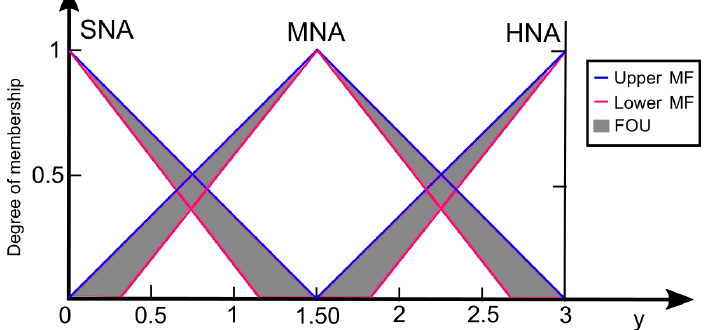
Figure 8. Output variable the number of experienced road traffic accidents. Used notation: MF— membership function; FOU—footprint of uncertainty.